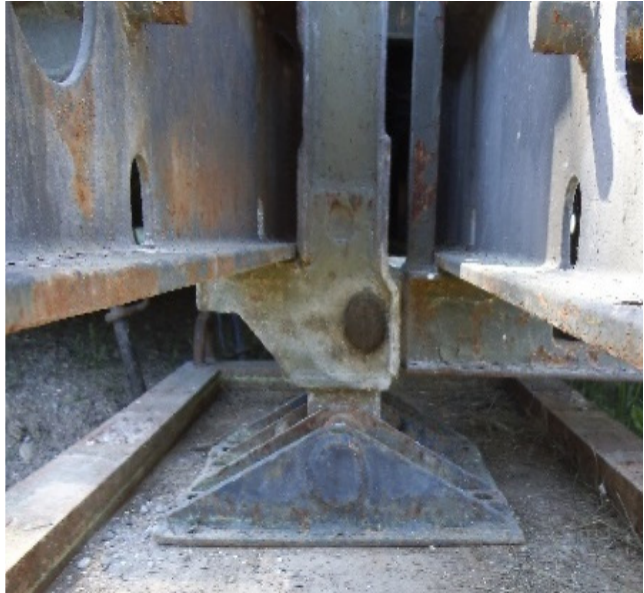
Figure 6. Bridge support.